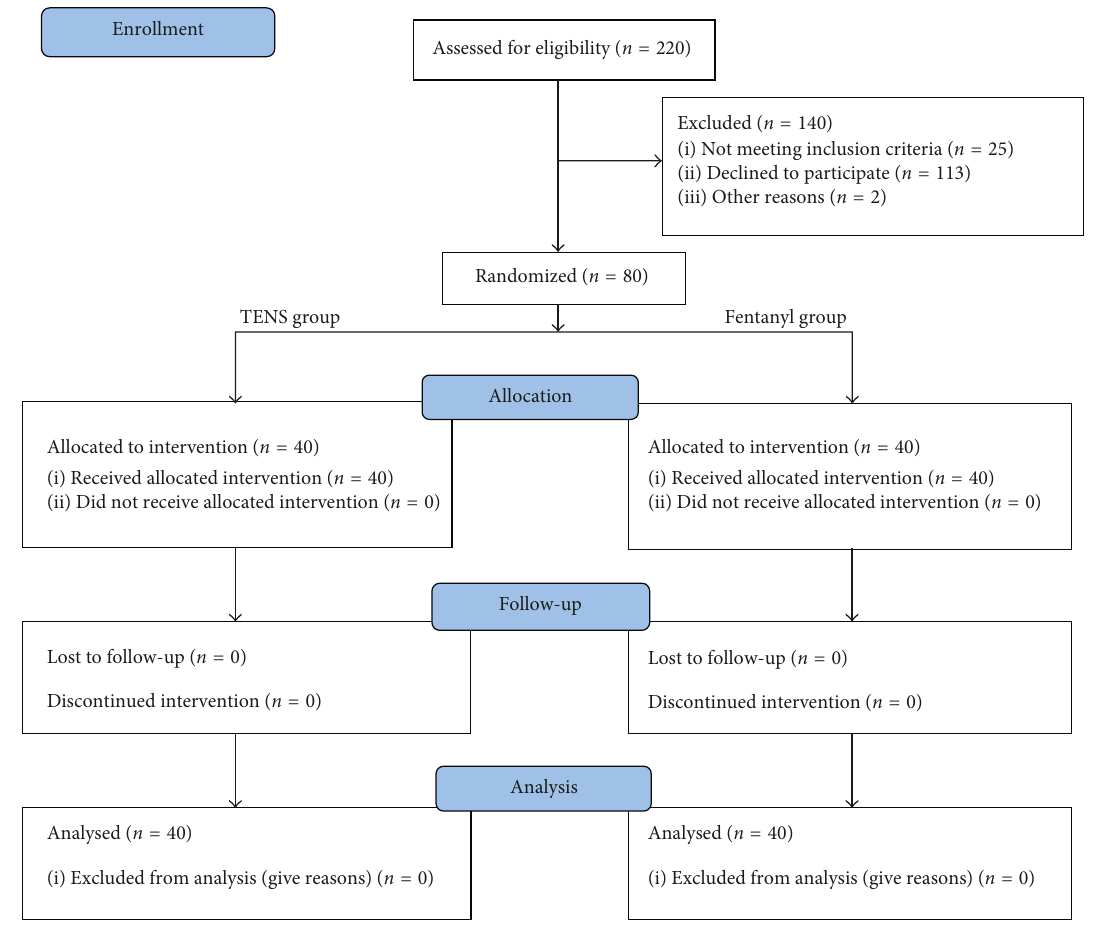
Figure 1: Flowchart of the study. Table 1: Patients’